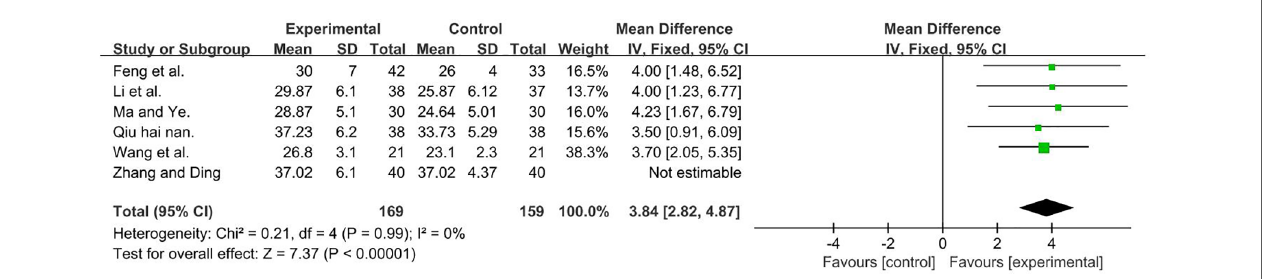
FIGURE 6 Forest plot showing MD (with 95% CI) for GMFM-C of the included studies comparing the experimental and control groups. Note: ( P =1 and I 2 =0%), fi xed- effect model [MD=3.84, 95% CI (2.82, 4.87); P <0.001]. The analysis results of three subgroups were statistically signi fi cant.